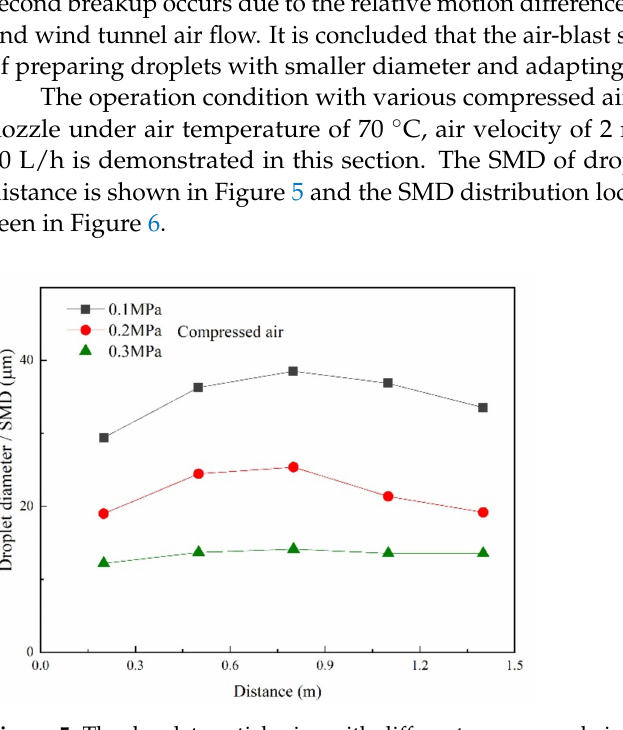
Figure 5. The droplet particle size with different compressed air pressure.